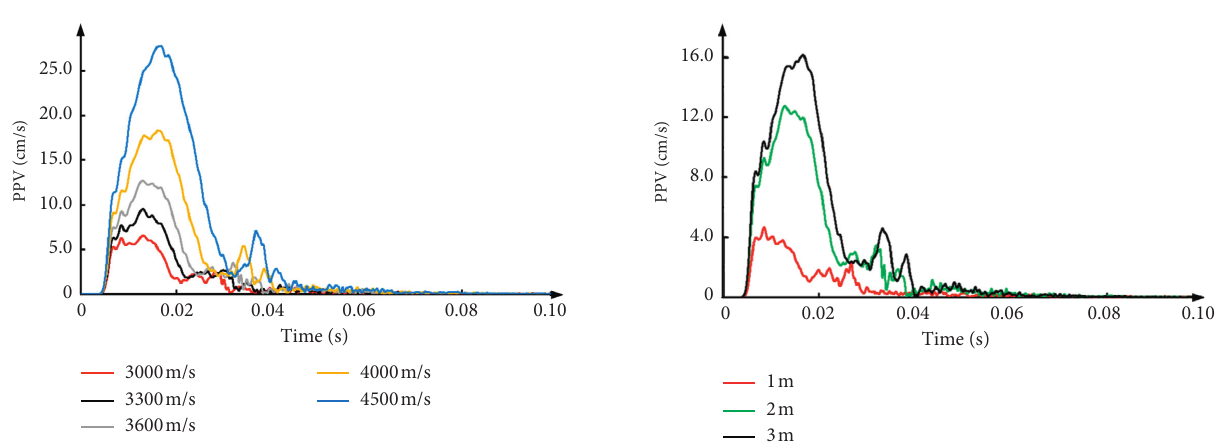
Figure 24: Changes of PPV of right wall with different digging length time versus time.